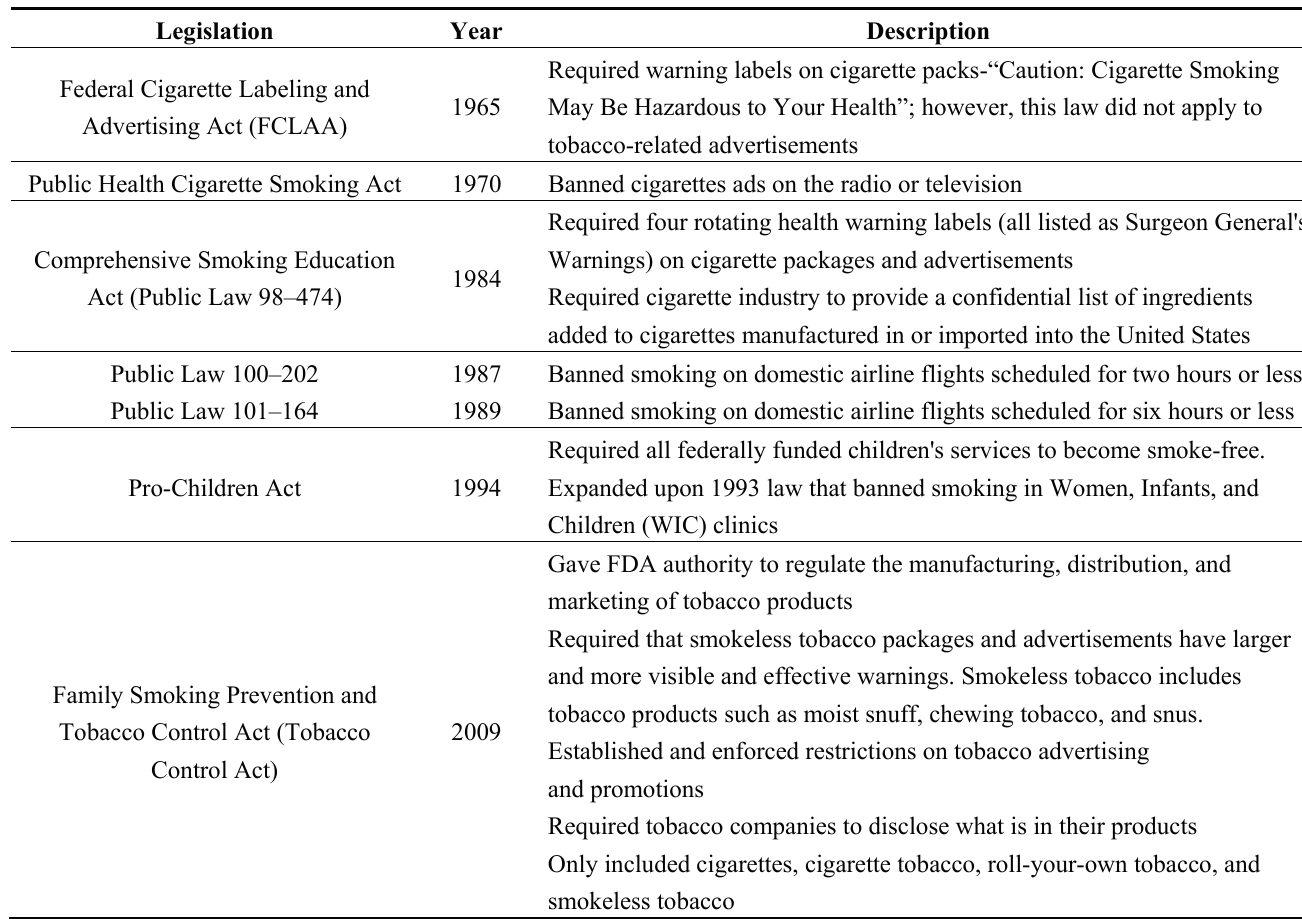
Table 1. Summary of federal tobacco product legislation